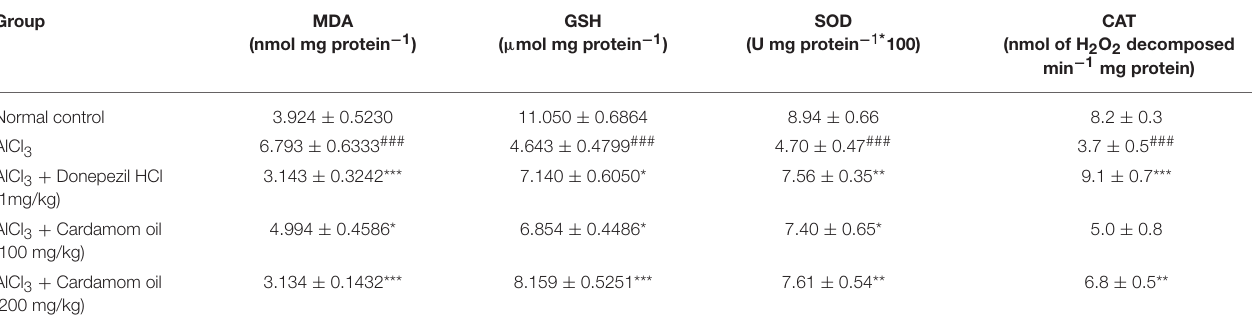
TABLE 3 | Effect of Cardamom oil on brain oxidative stress parameters in cortex. Group